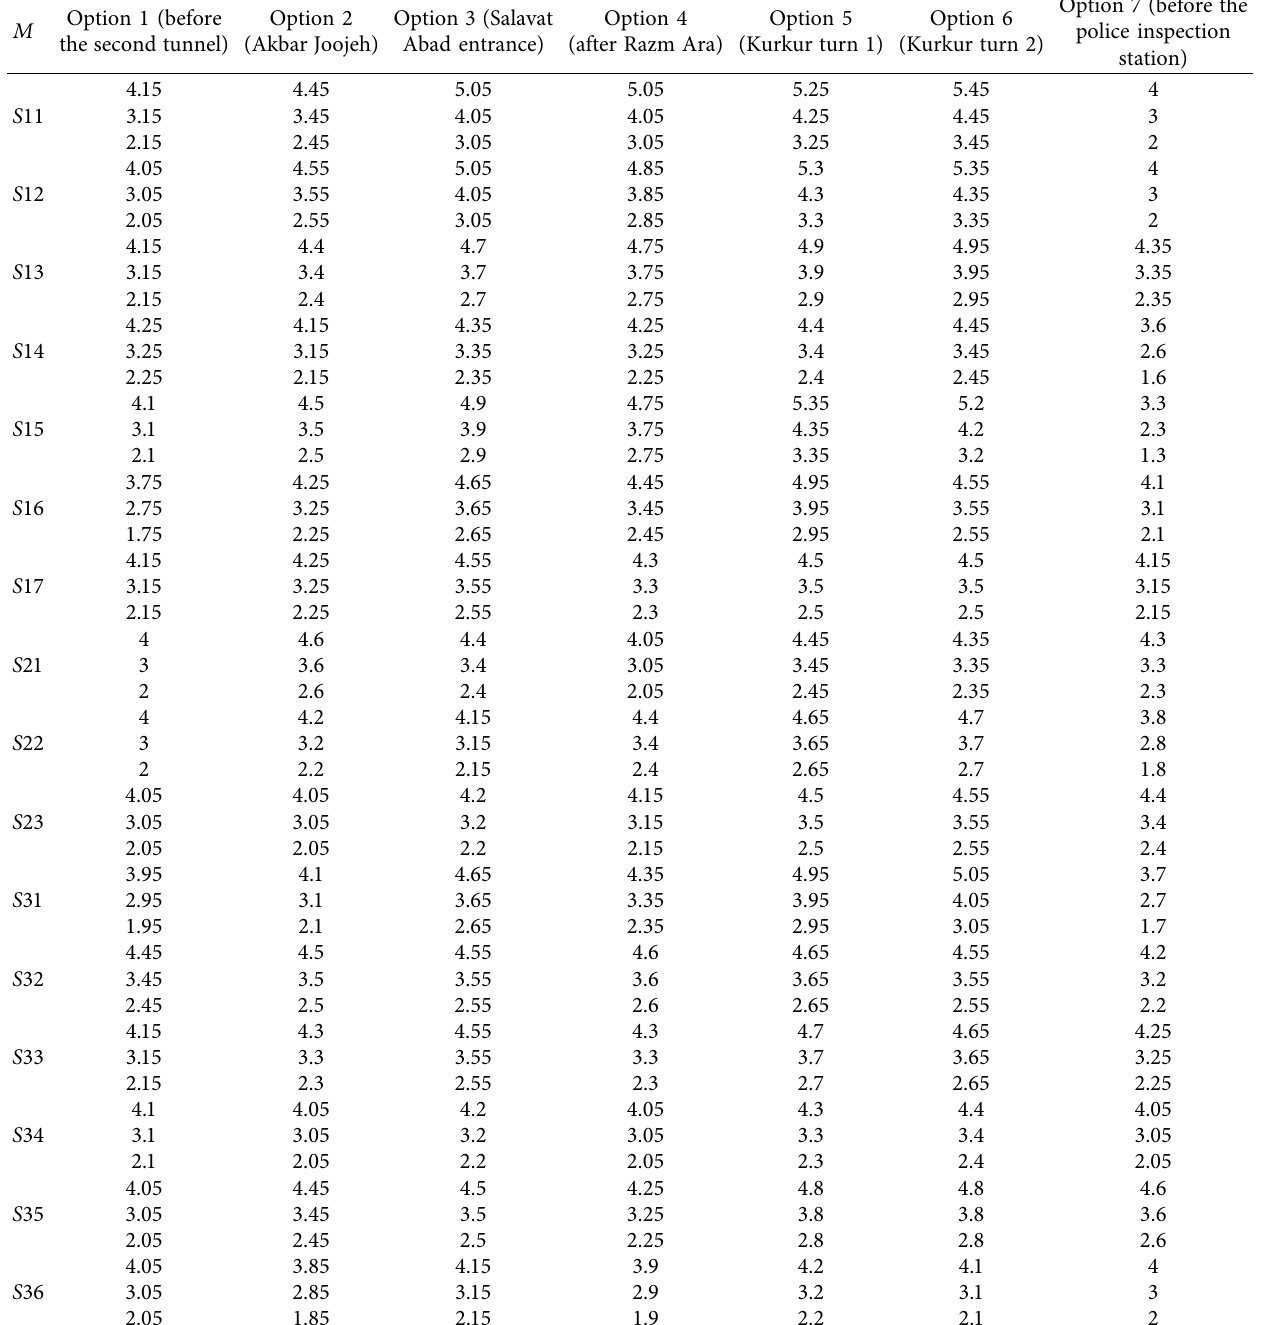
Table 12: TOPSIS technique decision